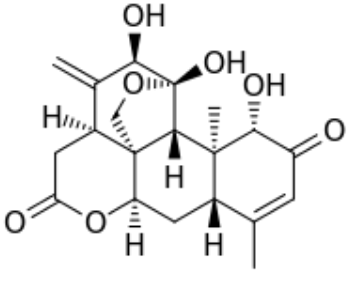
Figure 1. Ailanthone. Figure 1.